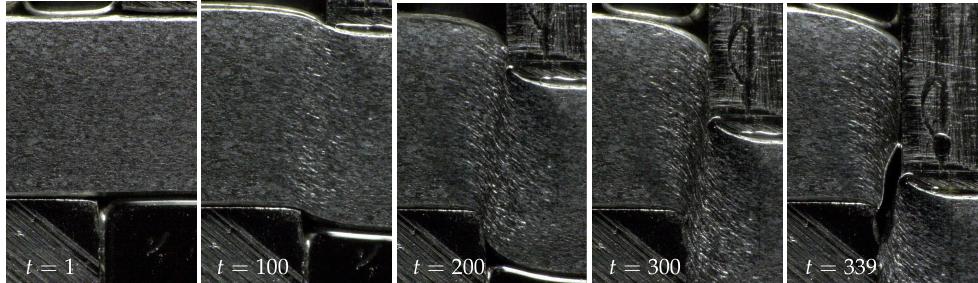
Figure 8. Image sequence of the sheet metal deformation and separation